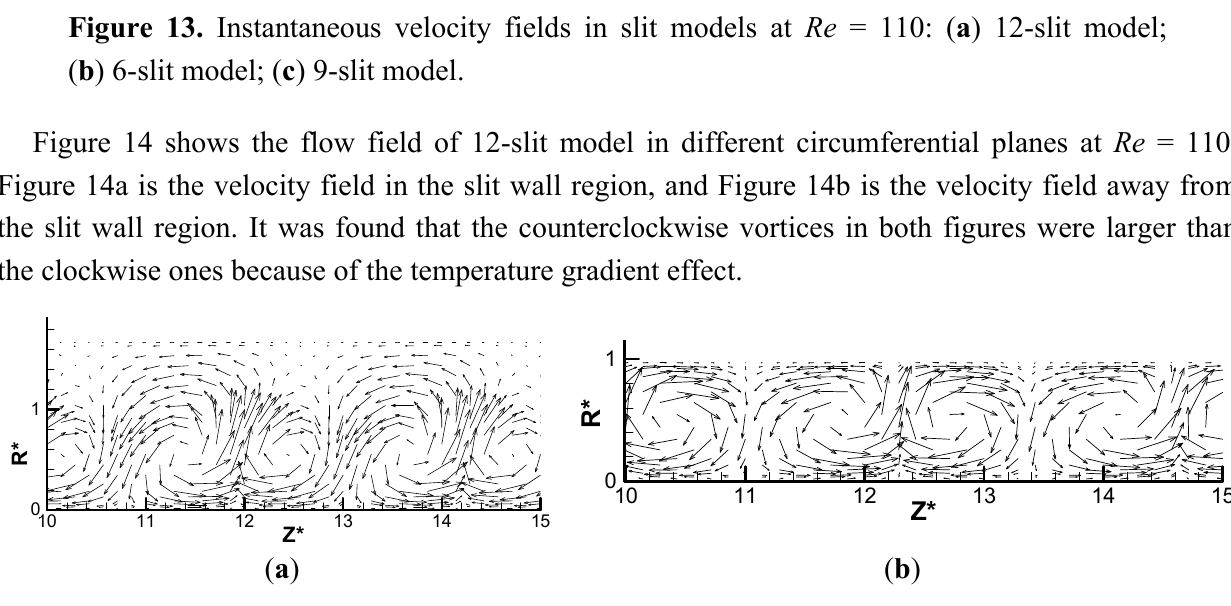
Figure 14. Instantaneous velocity in different circumferential planes. ( a ) In the slit wall region; and ( b ) Away from the slit